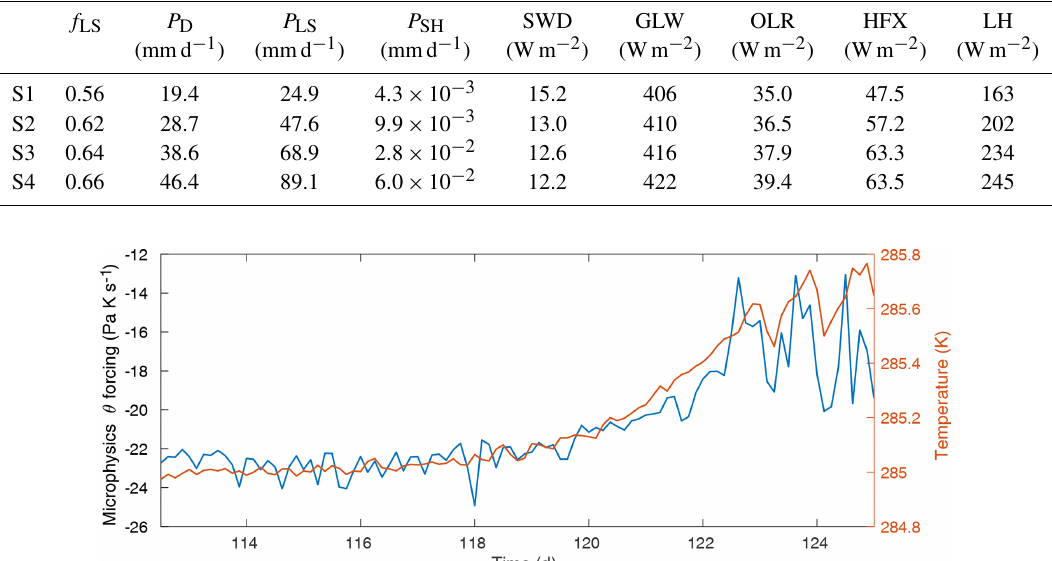
Table 3. Average values for a series of quantities for the four states from the experiment shown in Fig. 5. After f LS , the three types of precipitation (deep-convective P D , large-scale P LS , and shallow-convective P SH ) are shown, followed by the shortwave radiation to the surface (SWD), the outgoing longwave radiation from the ground (GLW), the outgoing longwave radiation at the top of the column (OLR), and the surface sensible (HFX) and latent (LH) heat fluxes.